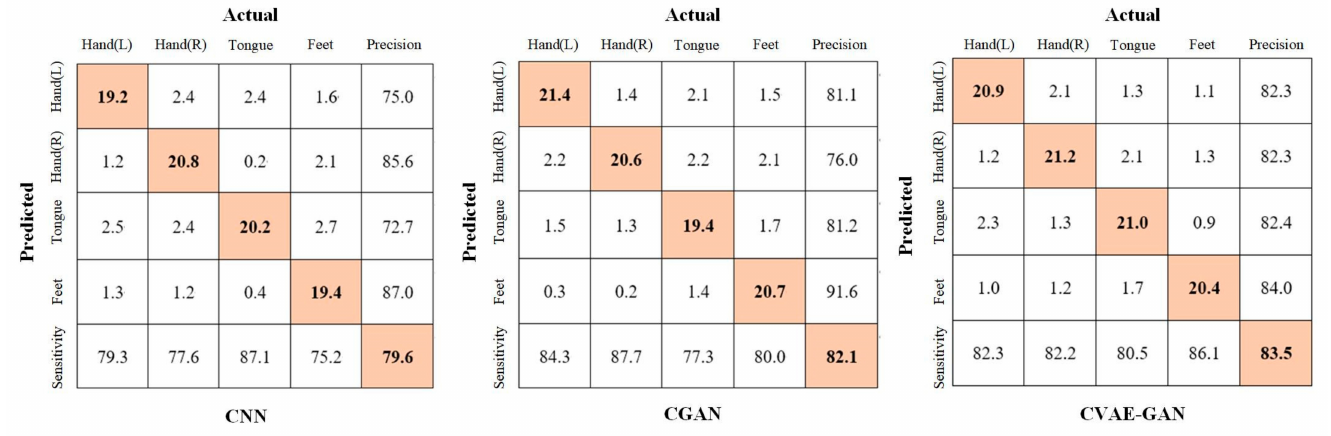
Figure 8. Classification performance of confusion matrices for the three methods.